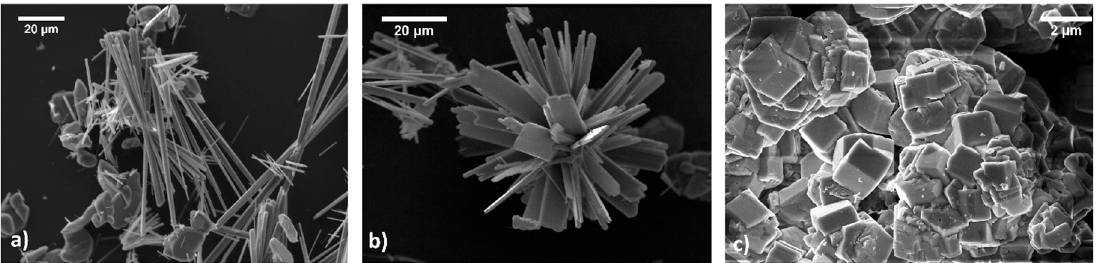
Figure 5. HAp grown from CO 2 —free solution ( a ) Apatite grown from CO 2 saturated solution ( b ) and CAp ( c ).